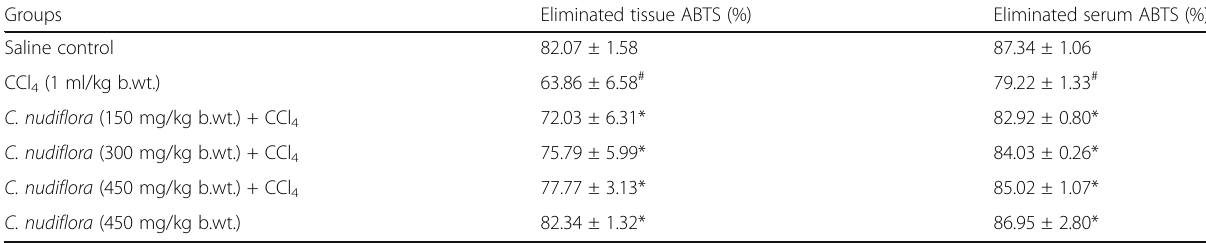
Table 6 Eliminated ABTS in hepatic tissue and serum of rats treated with C. nudiflora at various doses